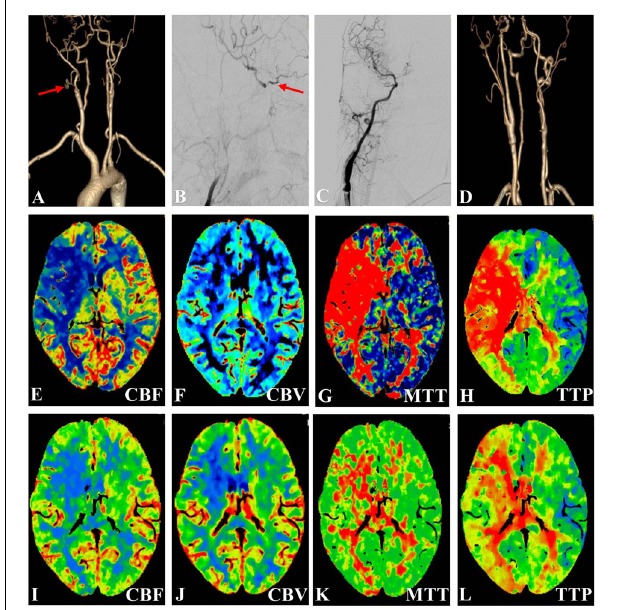
FIGURE 1 | Representative Case 1. A 67-year-old woman with right-sided limb weakness underwent hybrid surgery for internal carotid artery